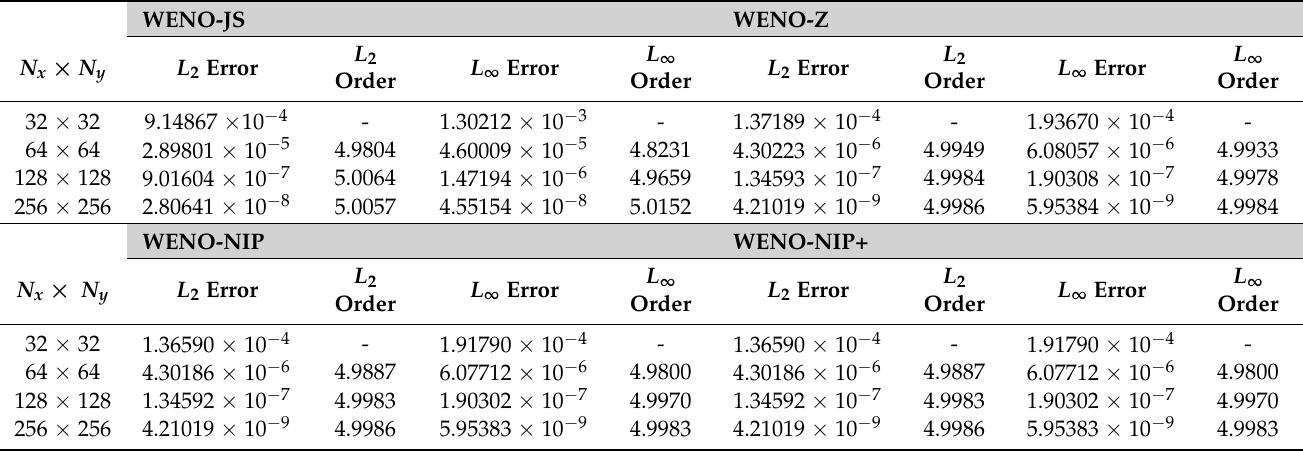
Table 1. Numerical errors and convergence orders of accuracy when solving Example 4, t = 2.0, CFL = h 2/3